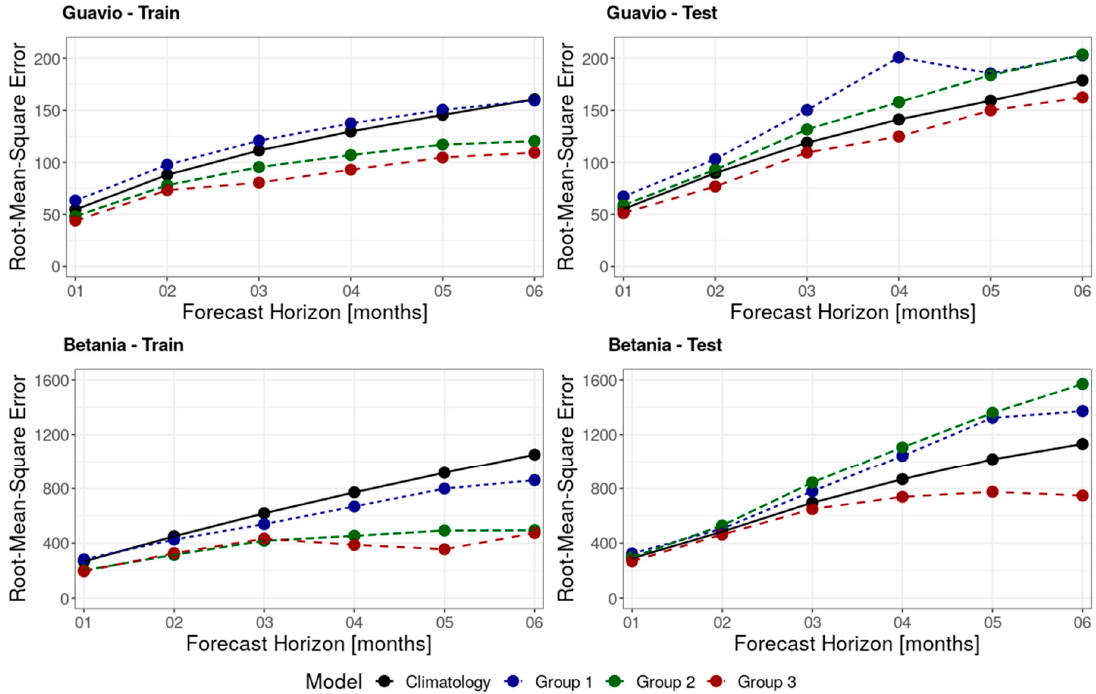
Figure 5. Root mean squared error results of the machine learning models and validation metrics per group.